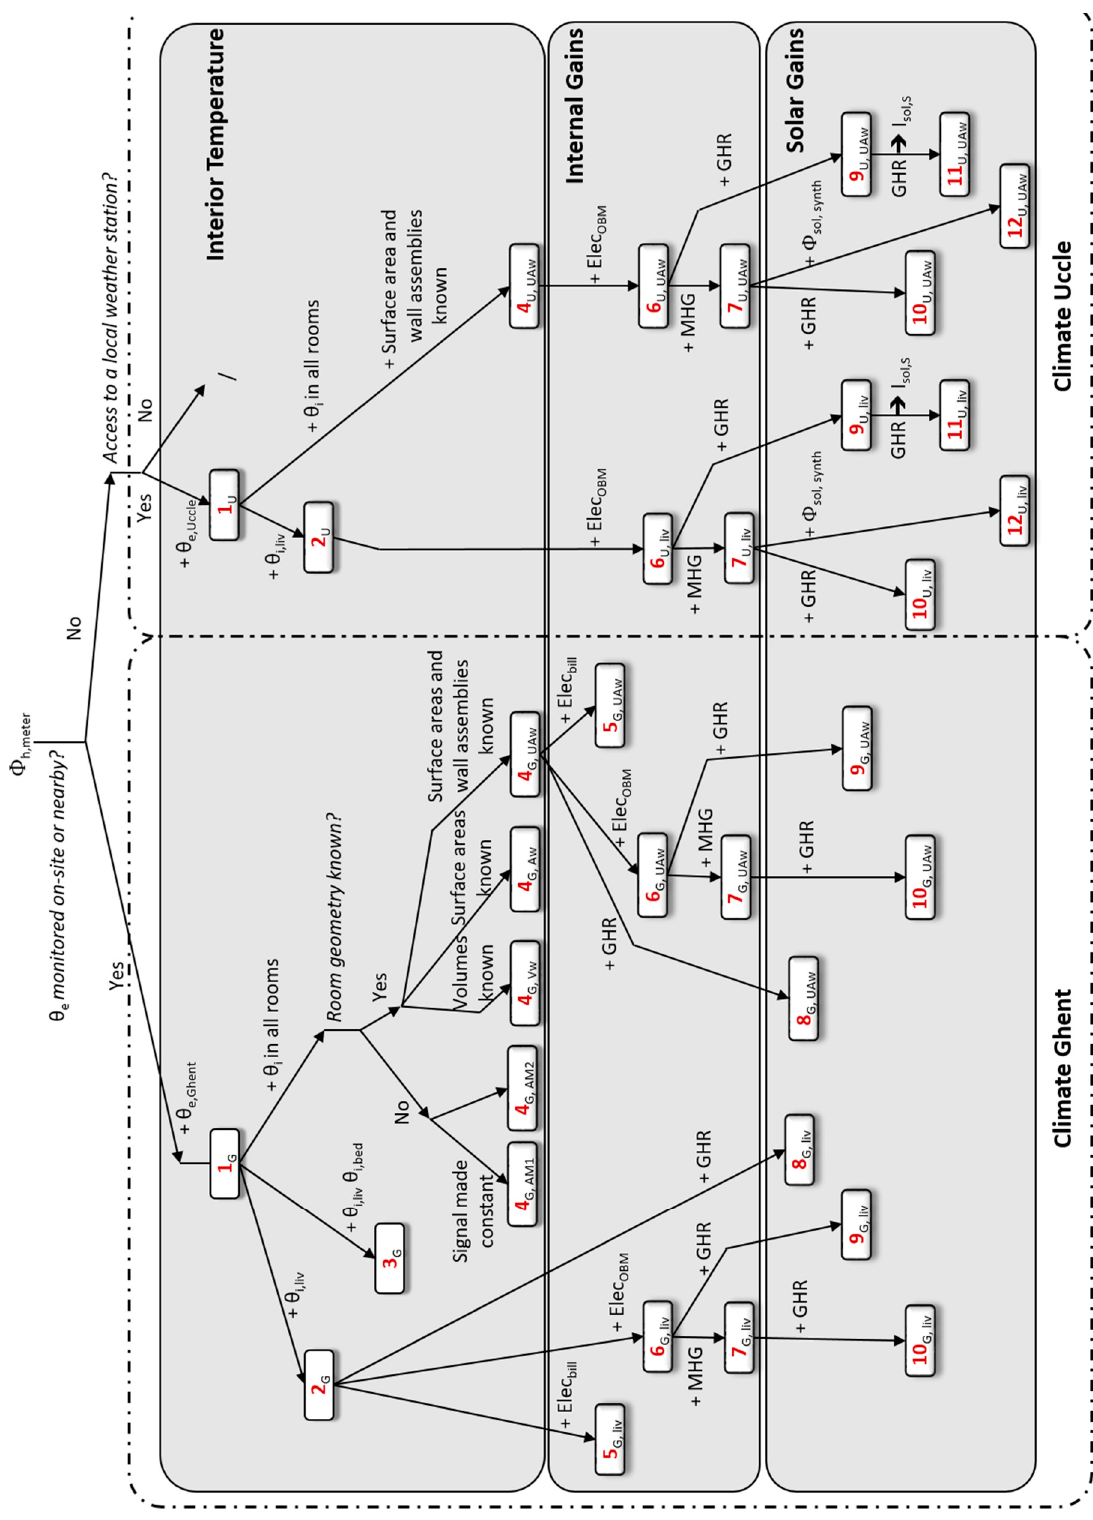
Figure 5. Schematic representation of the input data packages used in the sensitivity analysis. The abbreviations ‘liv’, ‘bed’, and ‘MHG’ stand for, respectively, ‘living room’, ‘bedroom’, and ‘metabolic heat gains’. Table 4 further details the content of the packages.